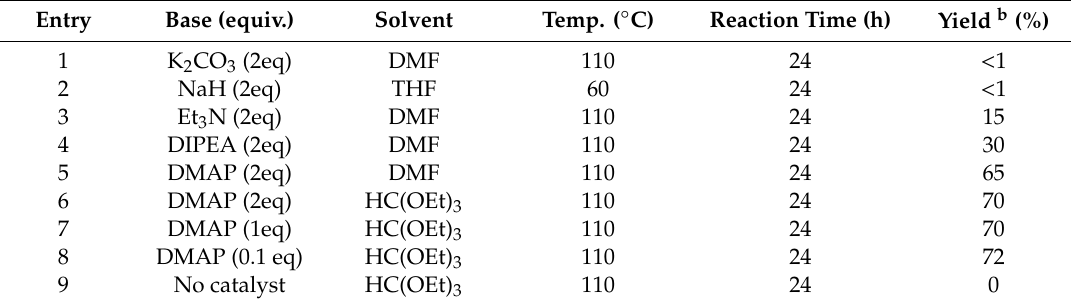
Table 2. Optimization of the reaction conditions a for the cyclocondensation.